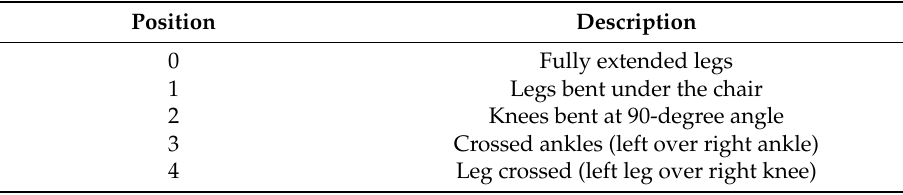
Table 2. Initial seated positions.